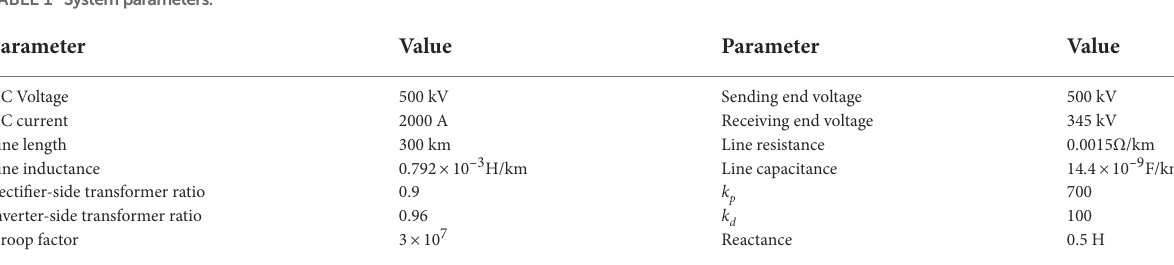
TABLE 1 Systemparameters.